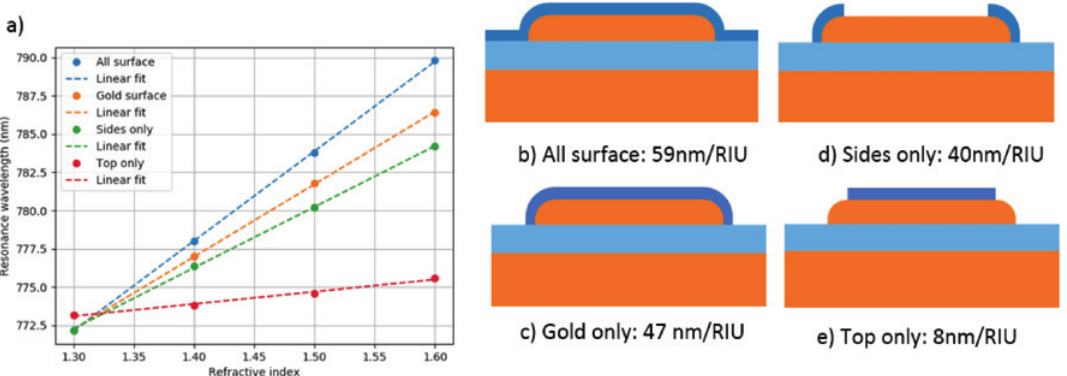
Figure 4: Comsolmodellinghighlightingthe sourceof theMIM peak surfacesensitivity.(a) Wavelength shifts resultingfrom coatingdifferent areasofthesensorsurface(b –